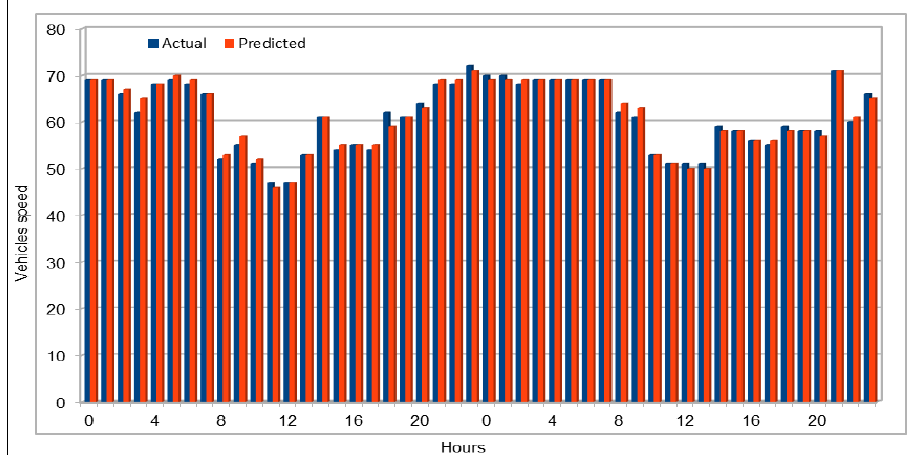
Figure 10. Traffic speed: Actual and predicted values (all VDS) (peak hour: 26 June 2017, 16:00–17:00).